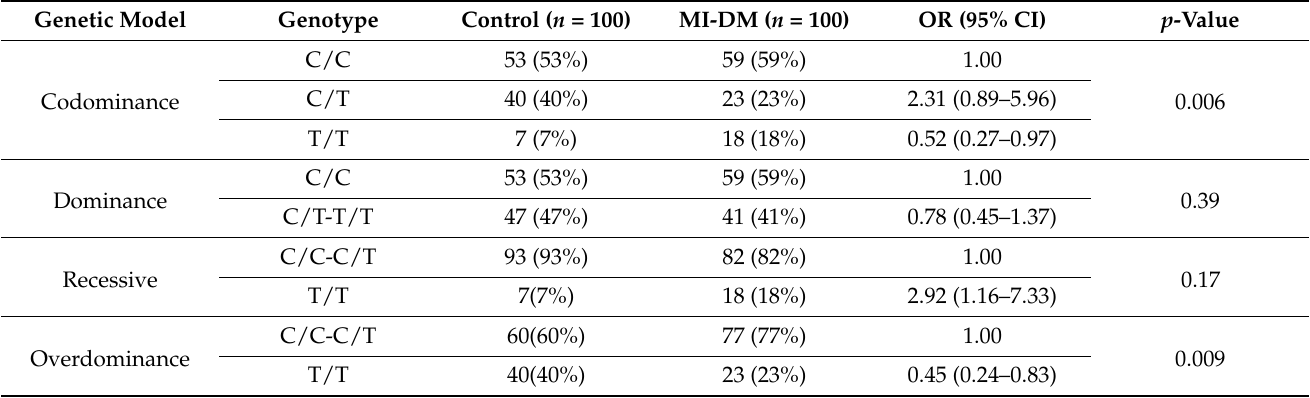
Table 6. Association of MTHFR C677T (rs1801133) single nucleotide polymorphism in the